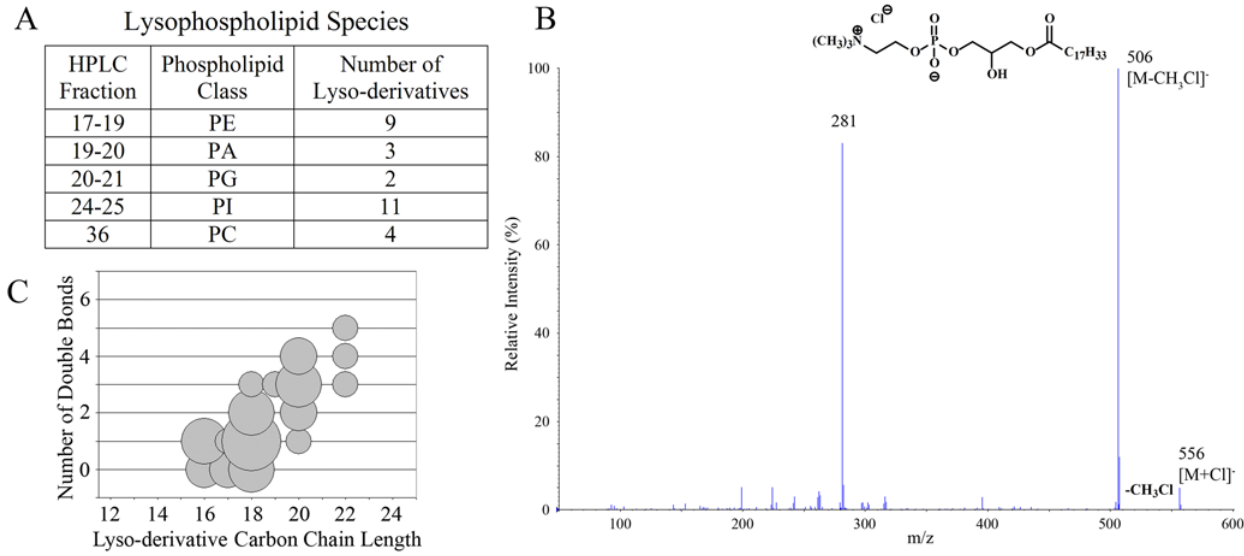
Figure 6. Identification of lysophospholipids . A variety of lyso-phospholipids (i.e. monoradyl species) were found in the CD1d ligand pool. A ) Table summarizing the types of lyso-phospholipids identified. B ) Negative ion MS/MS of ion m / z 556.5 from ion map of Fraction 36, containing the chloride ion adduct of C18:1/C0:0 PC (lyso-PC or LPC). Ion m/z 556 [M + Cl] 2 , gives rise to m/z 506 from the neutral loss of chloromethane ([M + Cl] 2 2 CH 3 Cl). The fatty acid 18:1 is indicated by the ion m/z 281. C ) Analysis of the carbon chains of the identified lyso-phospholipid species for the number of double bonds compared to chain length.